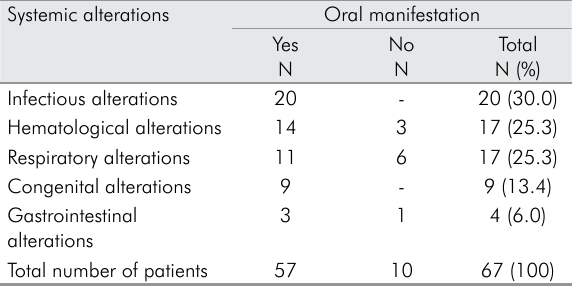
Table 4. Prevalence of systemic alterations according to cases of oral manifestation.